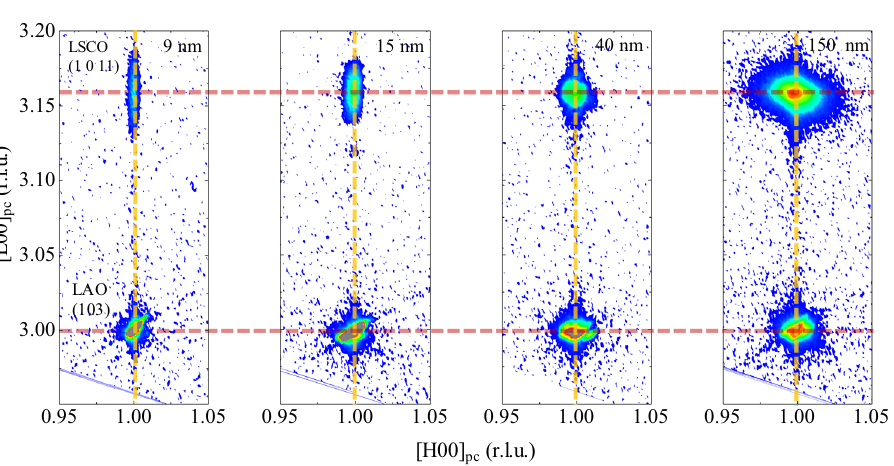
Figure 4. Reciprocal space maps of (1 0 11) film peak near (103) substrate peak for four different thick films. Reciprocal lattice unit (r.l.u.) is defined as 2 π divided by the pseudocubic lattice parameter (3.789 Å) of LaAlO 3 substrate. In-plane lattice parameters of the films exactly match with those of substrates, indicating fully strained films regardless of the different thicknesses. Out-of-plane lattice parameters are also almost same as a result of no significant strain